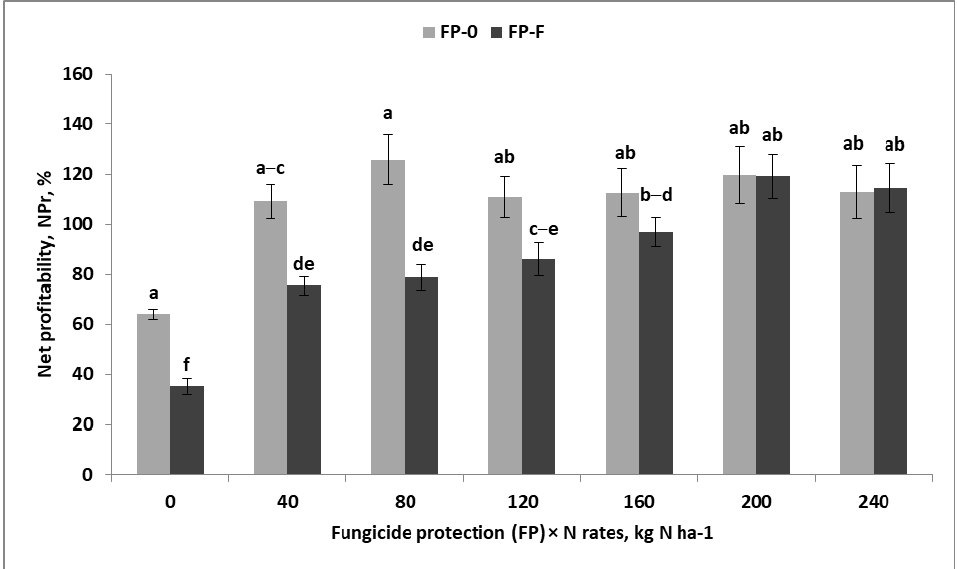
Figure 5. Effect of winter wheat protection with fungicides and rates of fertiliser nitrogen on profitability of grain production. Similar letters in the column means a lack of significant differences using Tukey’s test; the vertical bar in the column refers to the standard error of the mean.